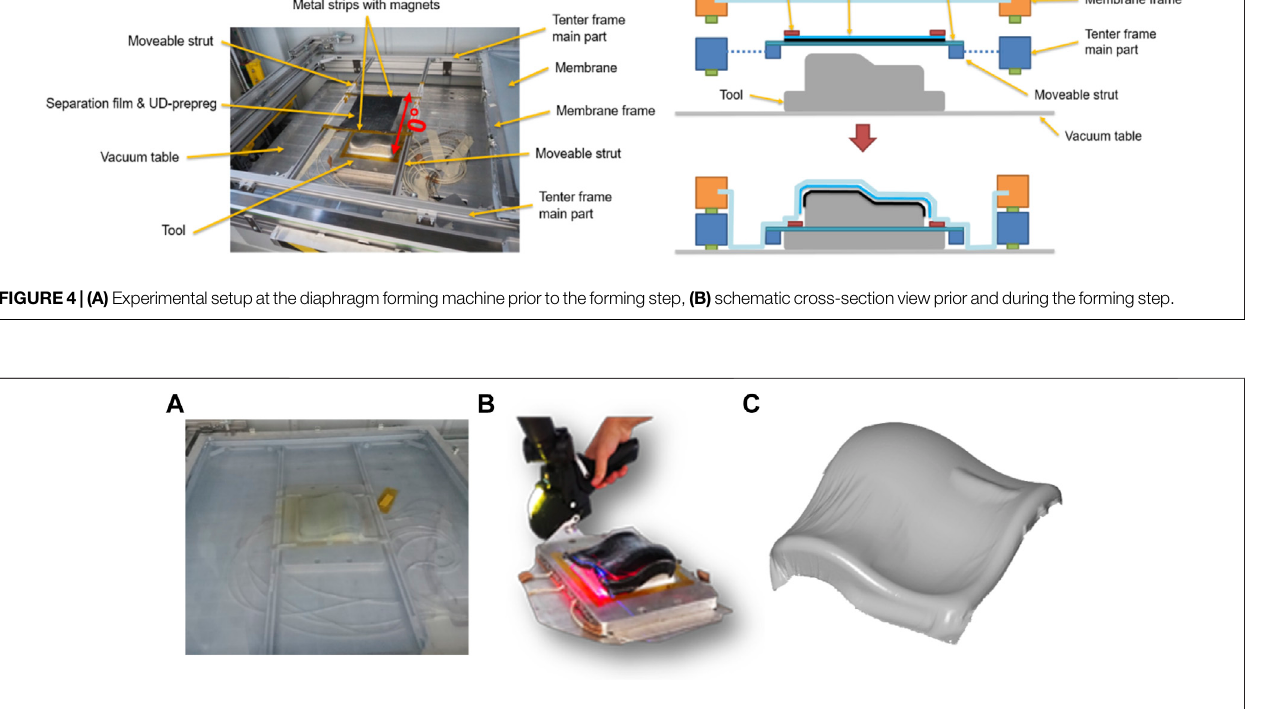
FIGURE 5 | (A) Forming step with vacuum application at the diaphragm machine, (B) 3D scanning of the deformed double sine geometry immediately after the forming step, (C) 3D scan data.